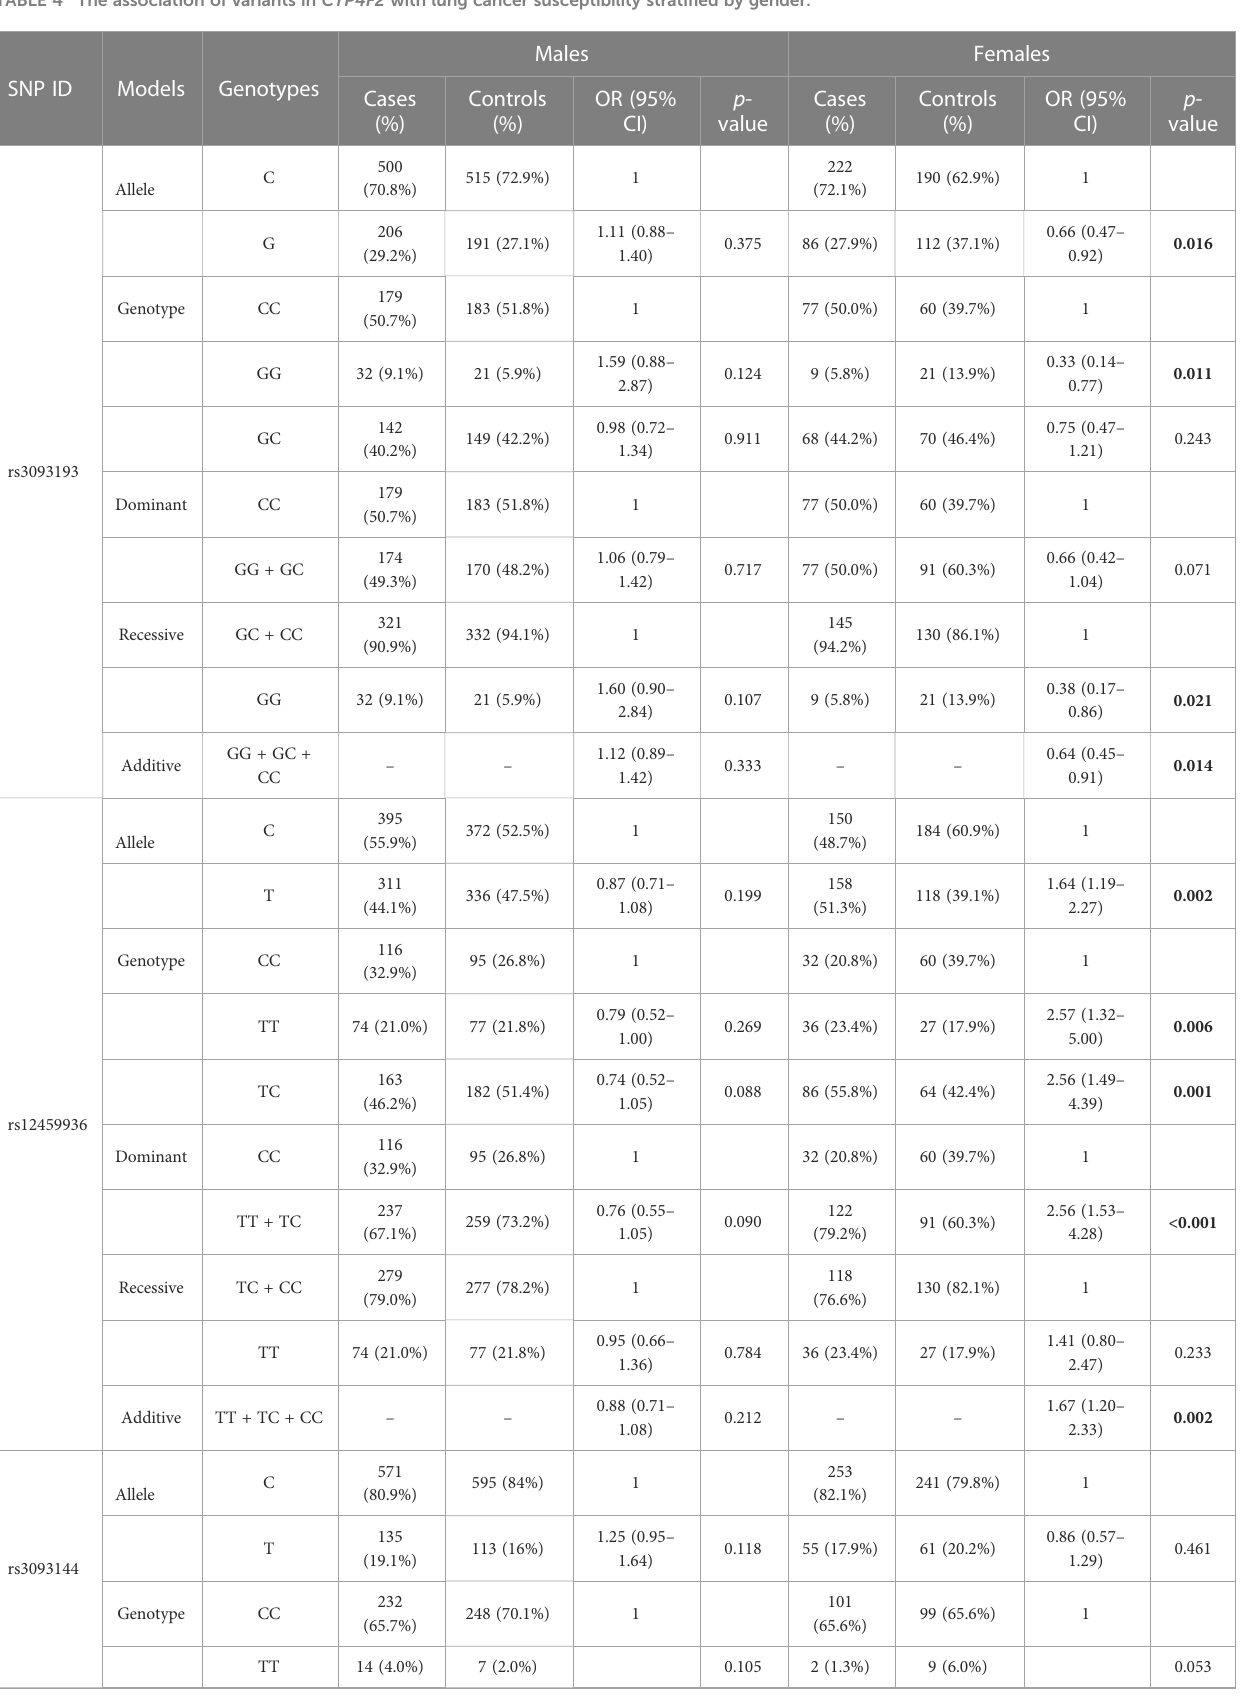
TABLE 4 The association of variants in CYP4F2 with lung cancer susceptibility strati fi ed by